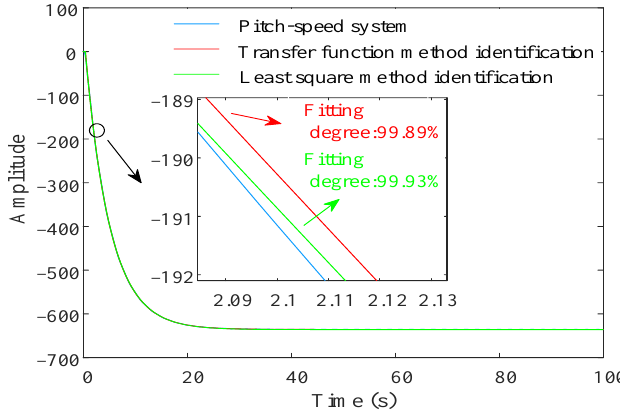
Figure 3. Comparison of unit open-loop step responses.